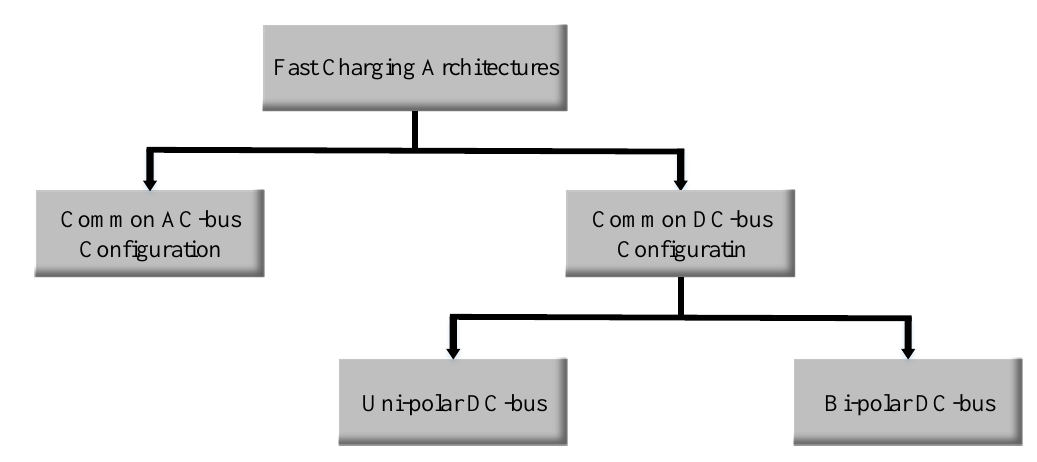
Figure 5. Classification of fast charging architectures.